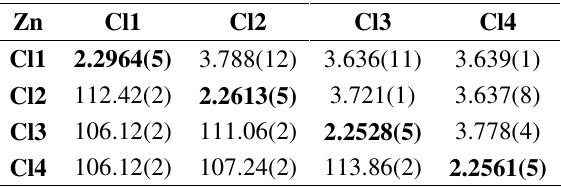
Table 2. Main inter-atomic distances (Å) and bond angles (°) in the inorganic groups